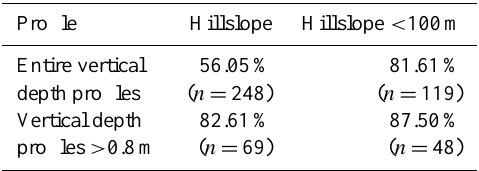
Fig. 8. Relationship between TWI and the Inter Quartile Range IQR (a) and standard deviation SD (b) of the vertical depth deuterium profiles.